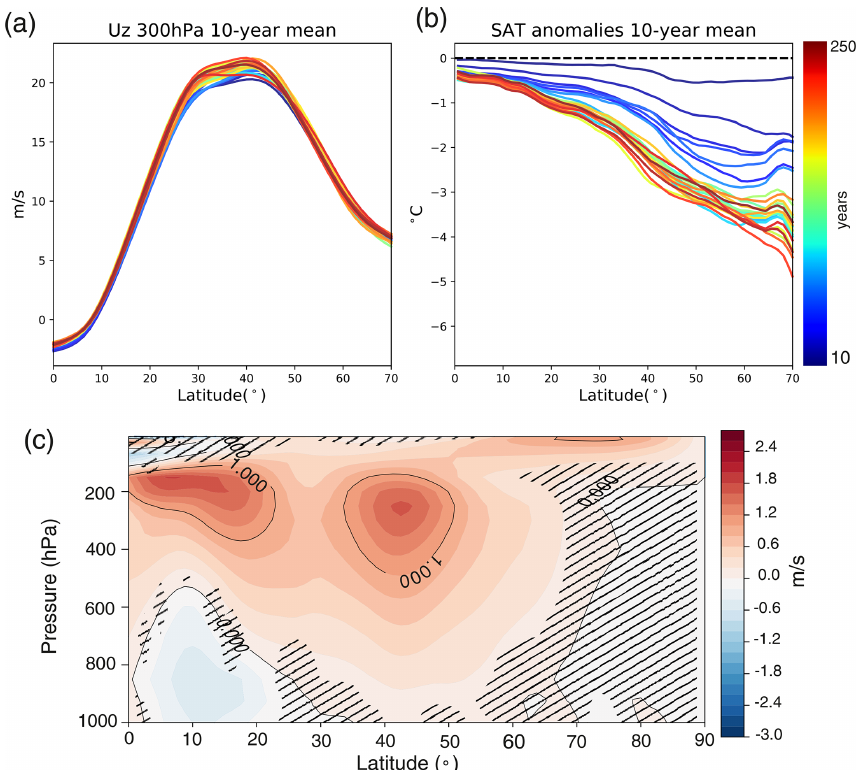
Figure 6. Each line in panel (a) corresponds to a 10-year mean of the zonal mean zonal wind U at 300hPa for the LIG_hosing run. Similarly, in panel (b) , each line represents a 10-year mean of LIG_hosing–LIG surface air temperature (SAT) anomalies. Panel (c) shows the long-term mean of zonal mean zonal wind LIG_hosing–LIG anomalies. Non-hatched areas correspond to statistically significant differences (at 95%